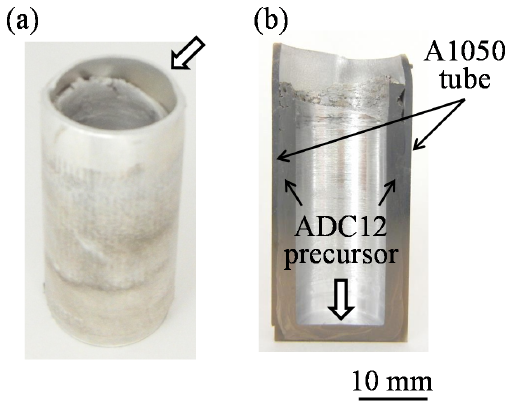
Figure 3. Fabricated ADC12 ‐ precursor ‐ bonded A1050 tube. ( a ) Sample immediately after friction welding; ( b ) Cross section of sample in ( a ).